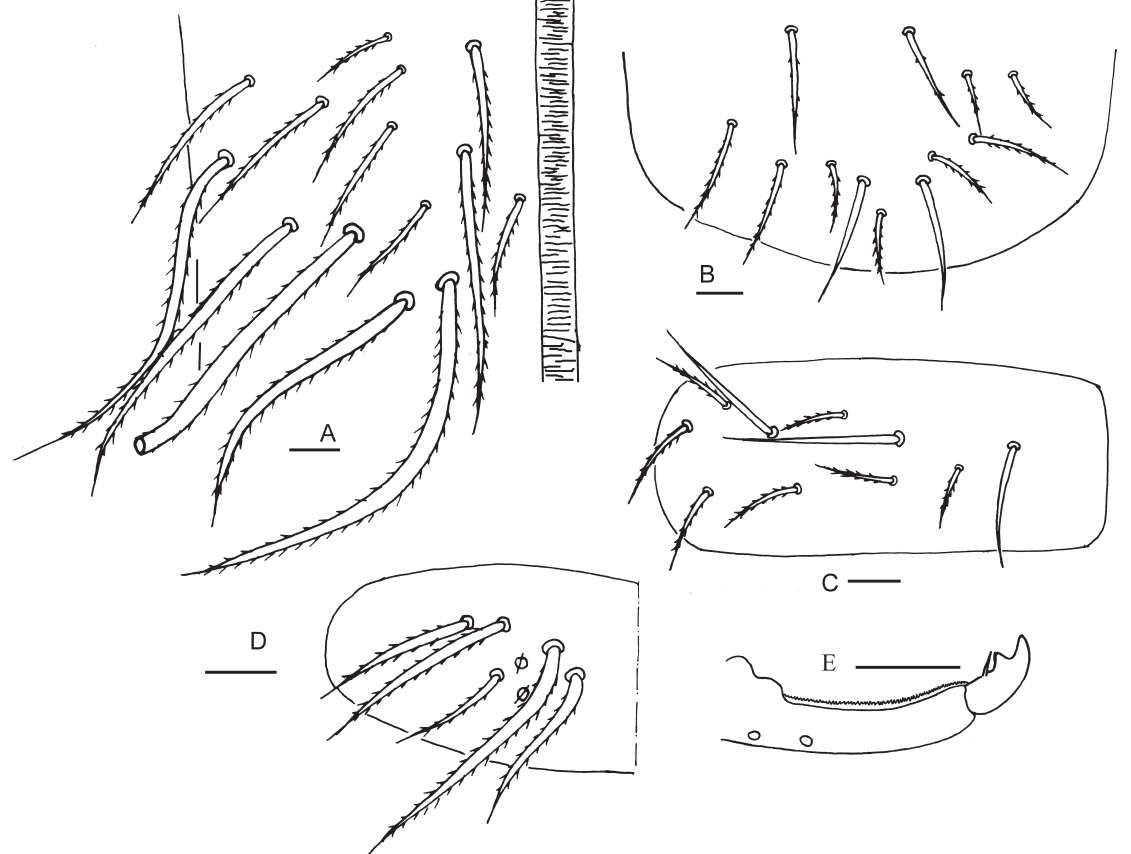
Fig. 15. Entomobrya dingi sp. nov. A . Anterior face of ventral tube. B . Posterior face of ventral tube. C . Lateral flap of ventral tube. D . Plaque of manubrium. E . Distal part of dens and mucro. Scale bars: A–E = 20